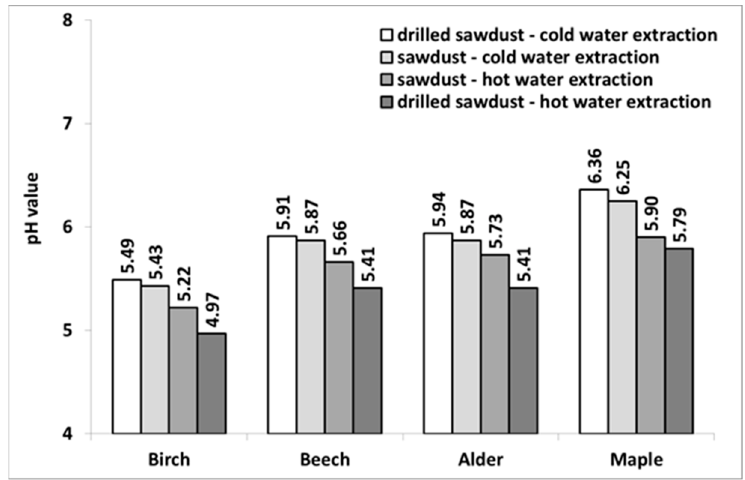
Figure 7. The pH value of cold water and hot water extractions .